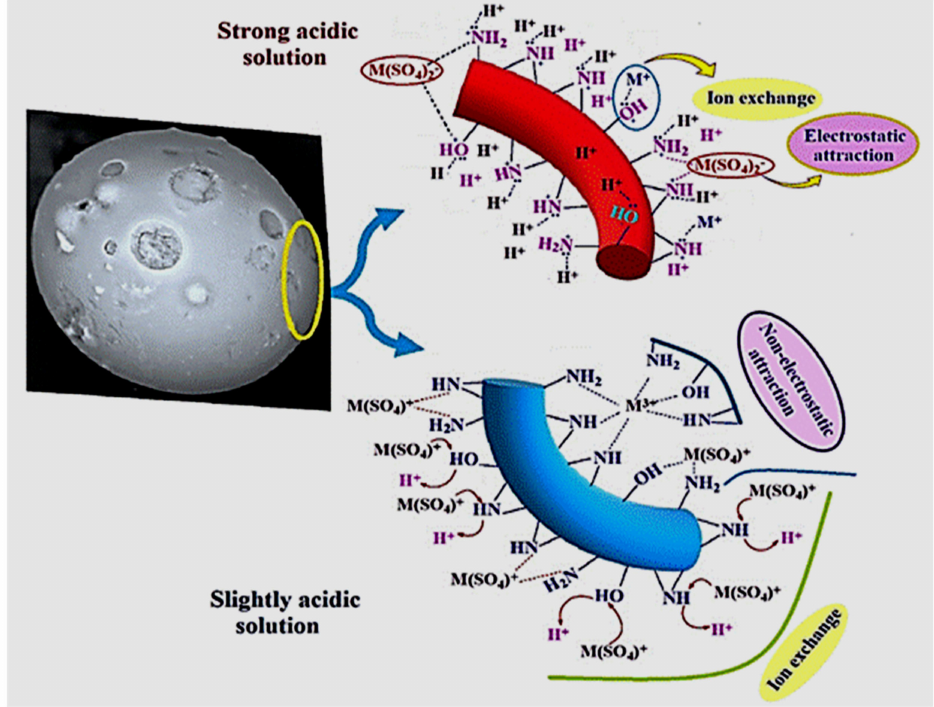
Figure 6. Tentative mechanisms for rare-earth elements (REEs) sorption on mesoporous NH/SiO 2